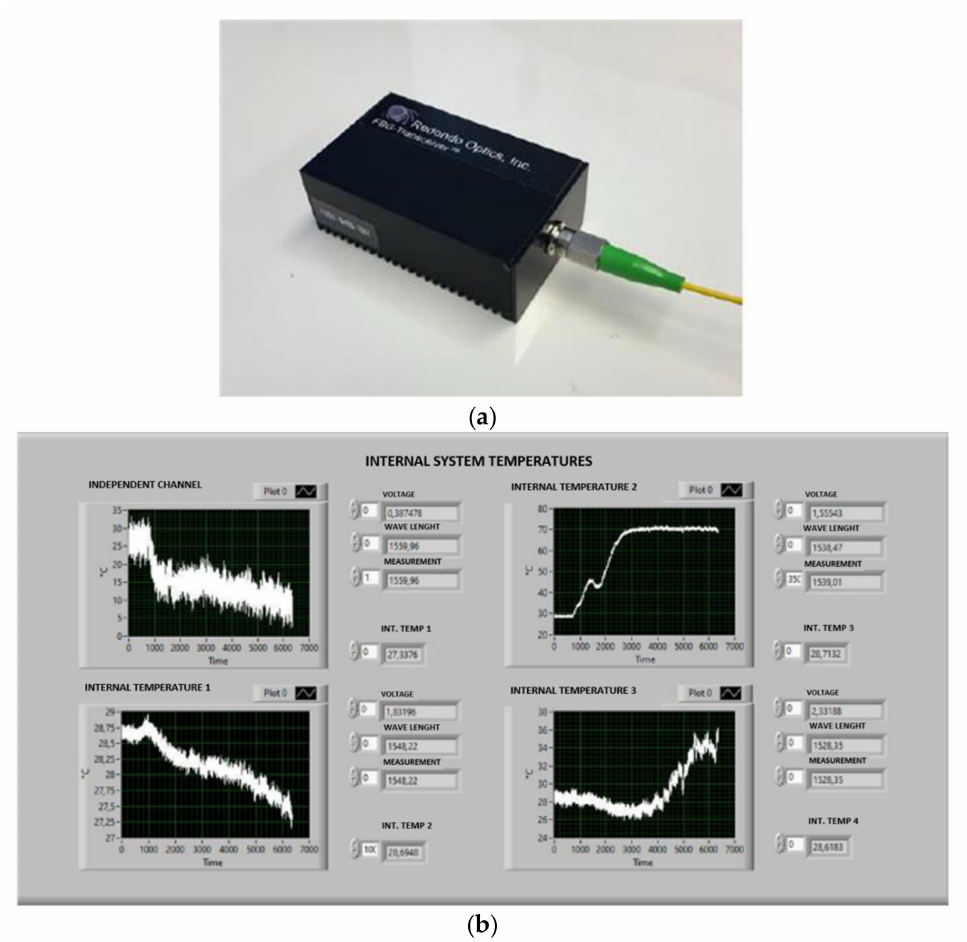
Figure 6. Temperature measurement system using FBG temperature sensor. ( a ) Measure- ment/interrogation unit ( b ) Graphical interface for temperature reading as function of